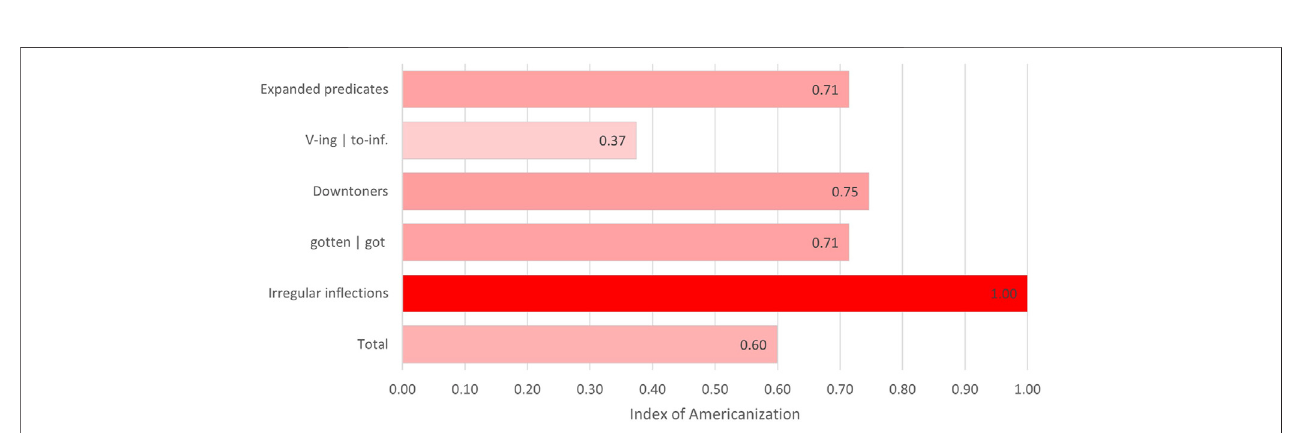
FIGURE 7 | Individual variation in the usage of morphological and lexico-grammatical variables presented as AmE index averages.